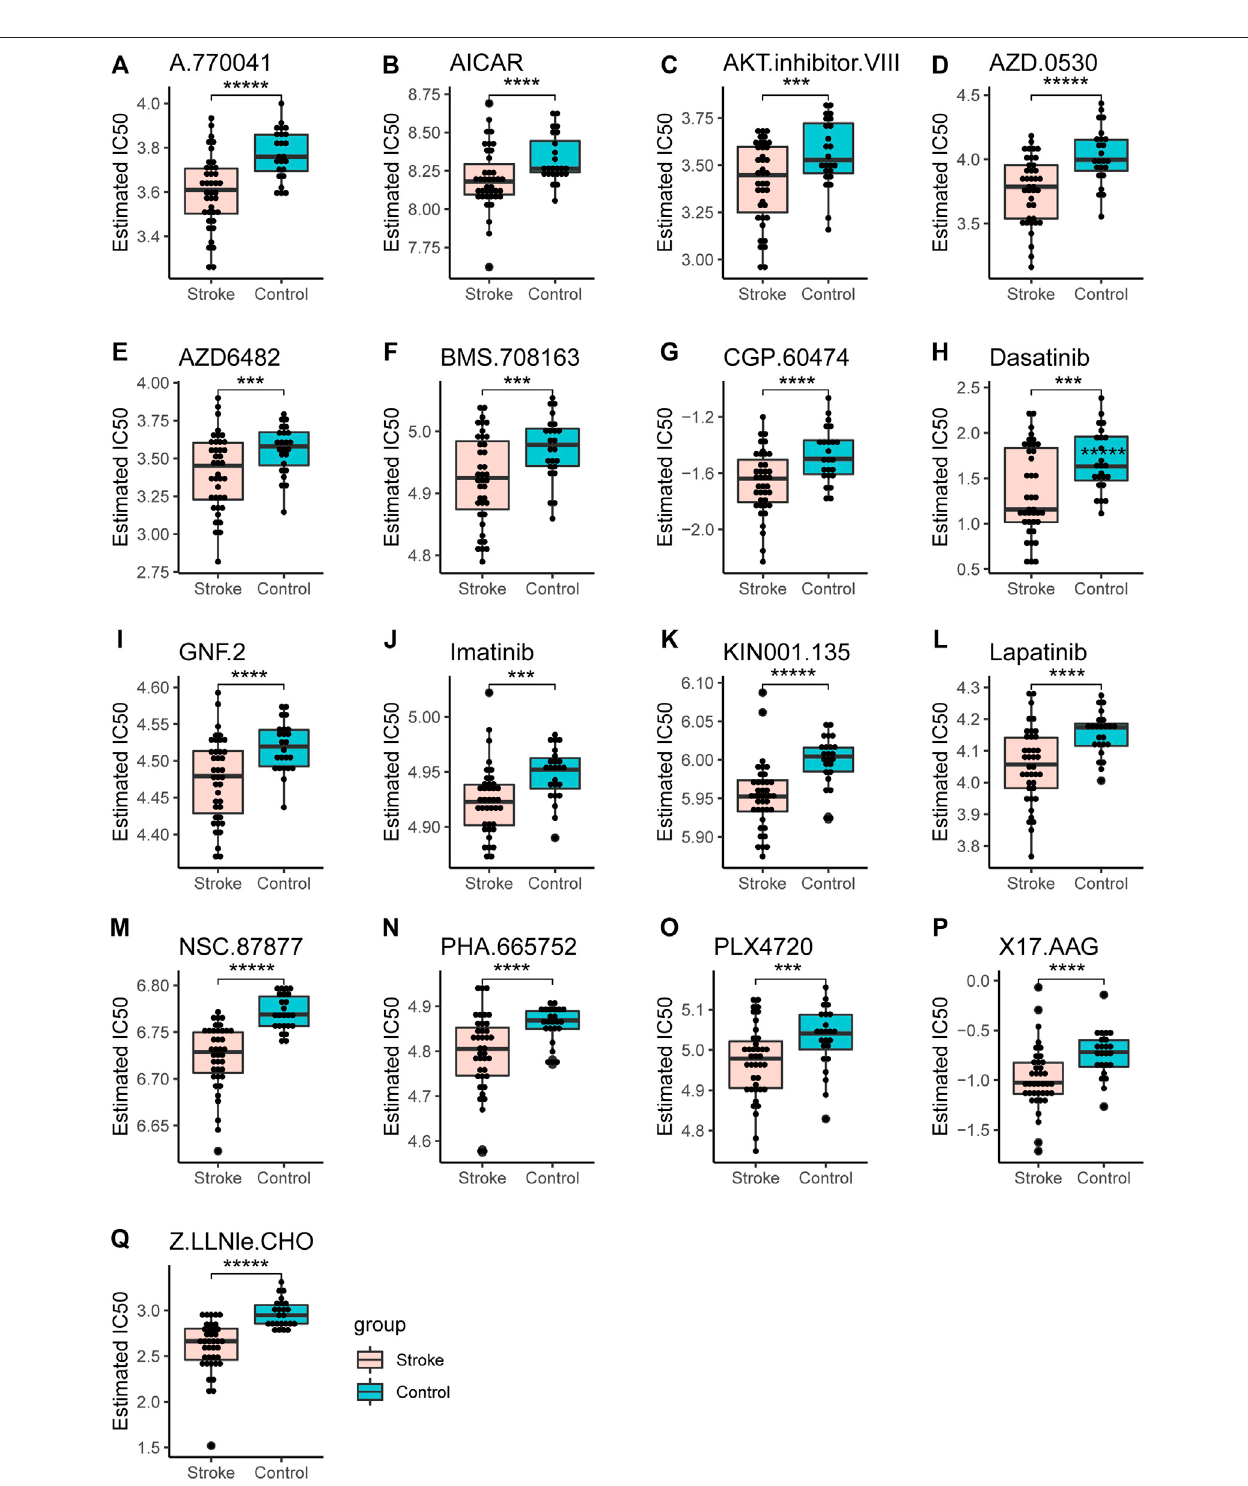
FIGURE 14 | Drug sensitivity analysis. The IC50 values of different drugs were determined in the control group and the acute cerebral infarction group. * p < 0.05, ** p < 0.01, *** p < 0.001, **** p < 0.0001, ***** p < 0.00001.